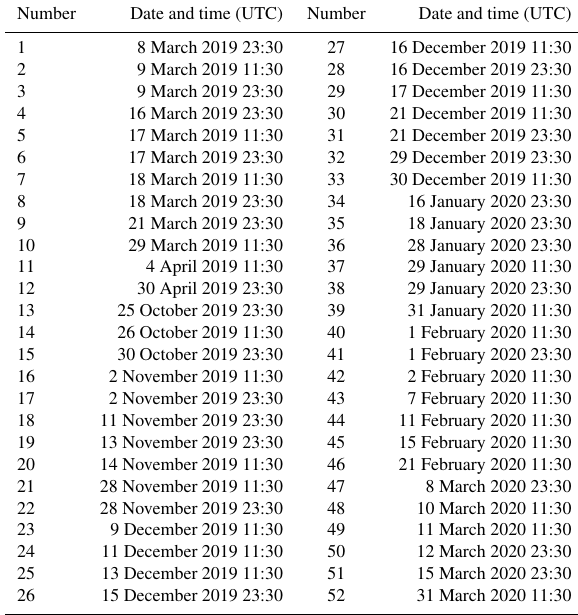
Table A2. Date and time for each of the 52 snowfall events coincid- ing with running mean RH ice ≥ 97% throughout the lower